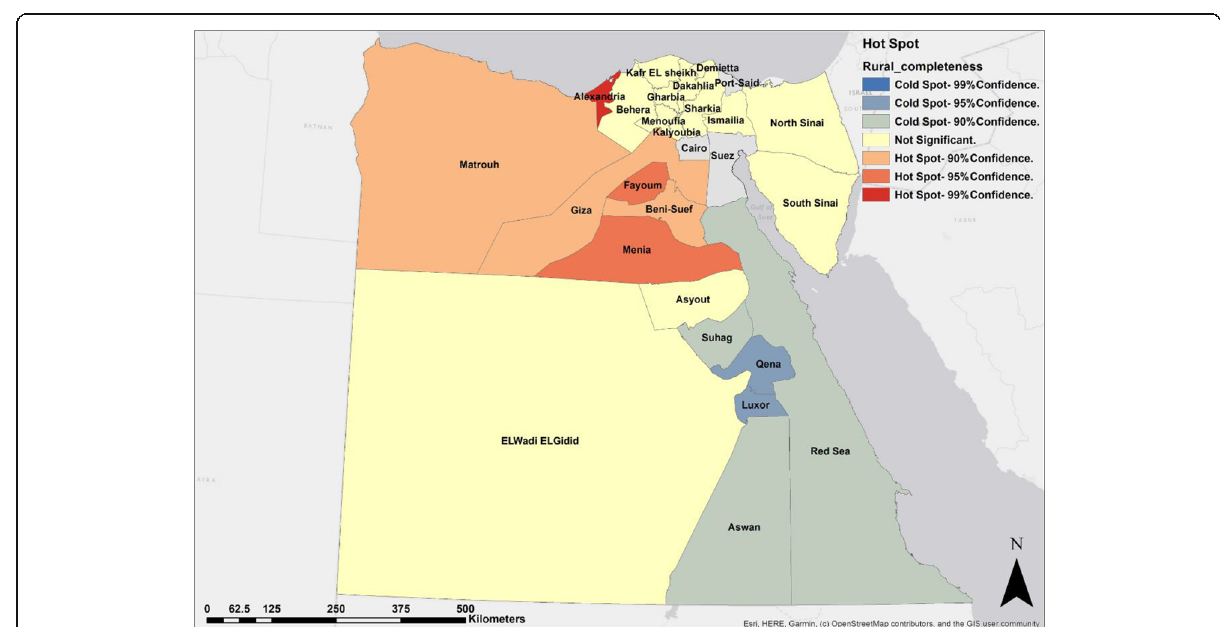
Fig. 6 Hot spots of the completeness of rural death registration, Egypt,